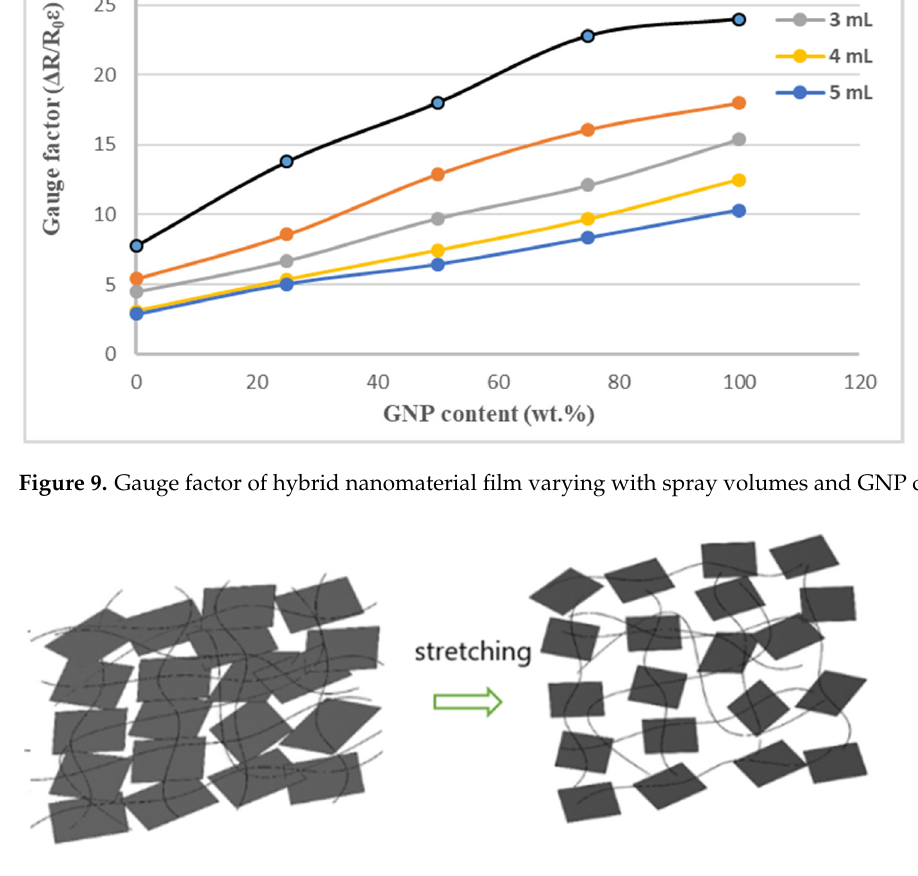
Figure 8. Resistance change vs. applied strain of the hybrid nanomaterial film with a fixed GNP content of 50 wt.% while the spray volume increased from 1 mL to 5 mL.